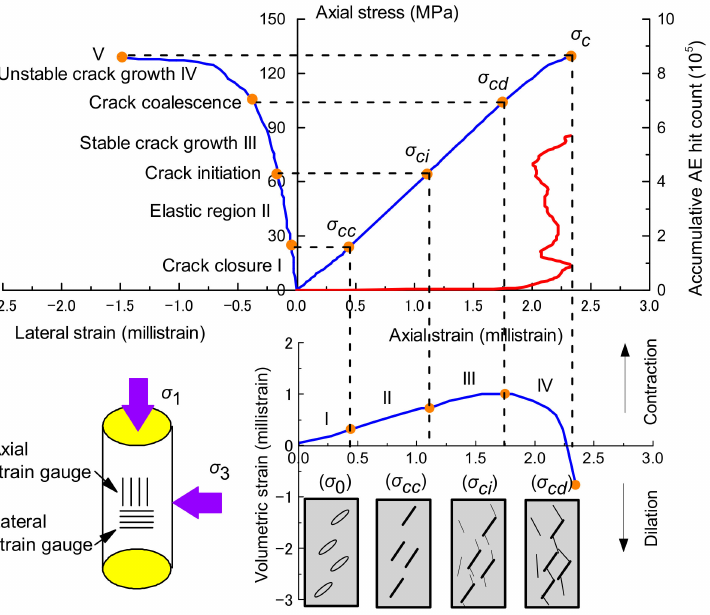
Figure 1. Stage division of the prepeak deformation and failure process of brittle rock. Reproduced from [19], Elsevier Science Ltd.: